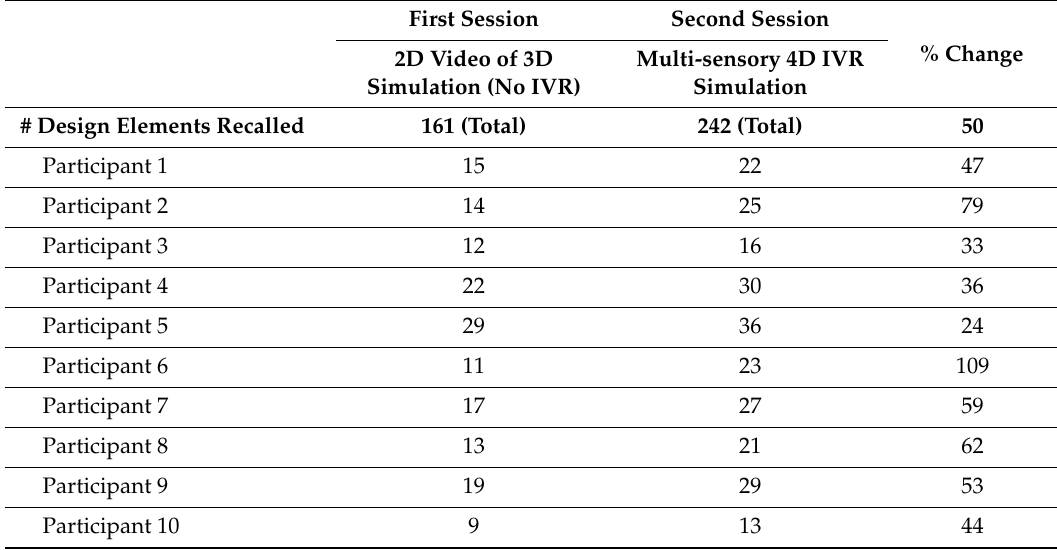
Table 3. Memory recall records on mental maps created by focus group 4